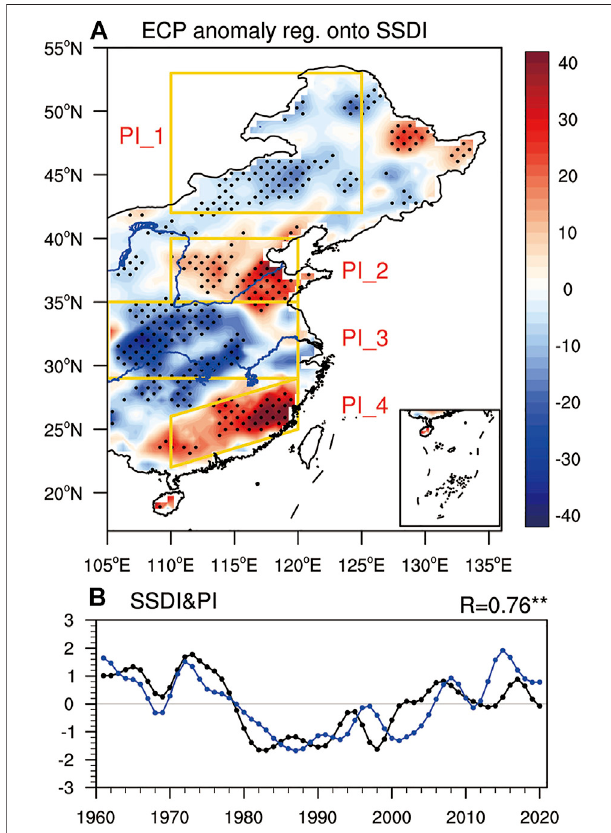
FIGURE 2 | (A) Eastern China precipitation anomaly in summer (JJA) regressed onto the SSDI. (B) shows the SSDI (blue line) and Precipitation index (PI, black line), where PI is de fi ned as the differences of rainfall between the standardized interdecadal component over the quadrangles with positive values (PI_2, PI_4) and negative values (PI_1, PI_3) shown in (A) . The stippling in (B) denotes the regression coef fi cients statistically signi fi cant at the 95% con fi dence level. R in (B) represents the correlation coef fi cients between SSDI and PI, where ** indicates the values passing the signi fi cance test at 99% con fi dence